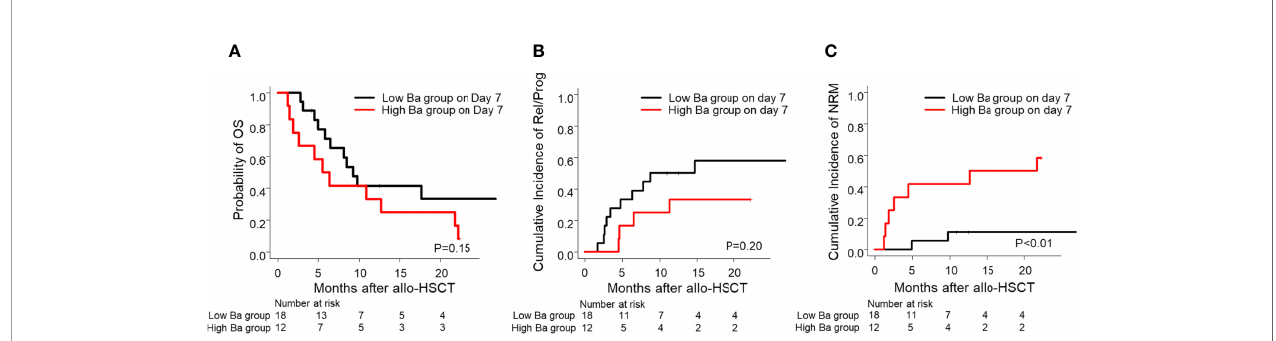
FIGURE 4 | Prognosis of allo-HSCT in patients with low and high Ba levels on Day 7 following allo-HSCT. The probability of OS (A) and the cumulative incidence of Rel/Prog (B) and NRM (C) are shown for the groups with low Ba (< 869.1 ng/ml) and high Ba ( ≥ 869.1 ng/ml) on Day 7 following allo-HSCT. allo-HSCT, allogeneic hematopoietic stem cell transplantation; NRM, non-relapse mortality; OS, overall survival; Rel/Prog,